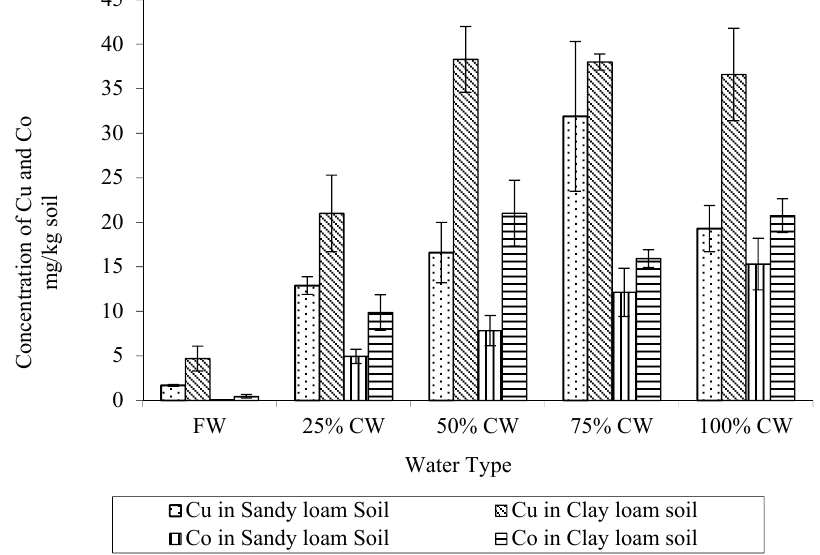
Figure 2. Concentration of Cu and Co in sandy loam and clay loam soils, which were used for growing pumpkin and Chinese cabbage and irrigated with increasing levels of contaminants in irrigation water. The error bars shown are the standard error of means.